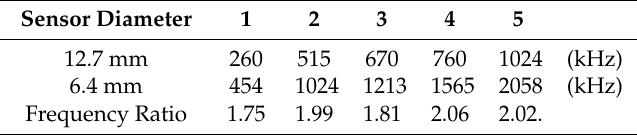
Table 2. Frequency of aperture null effects and null frequency